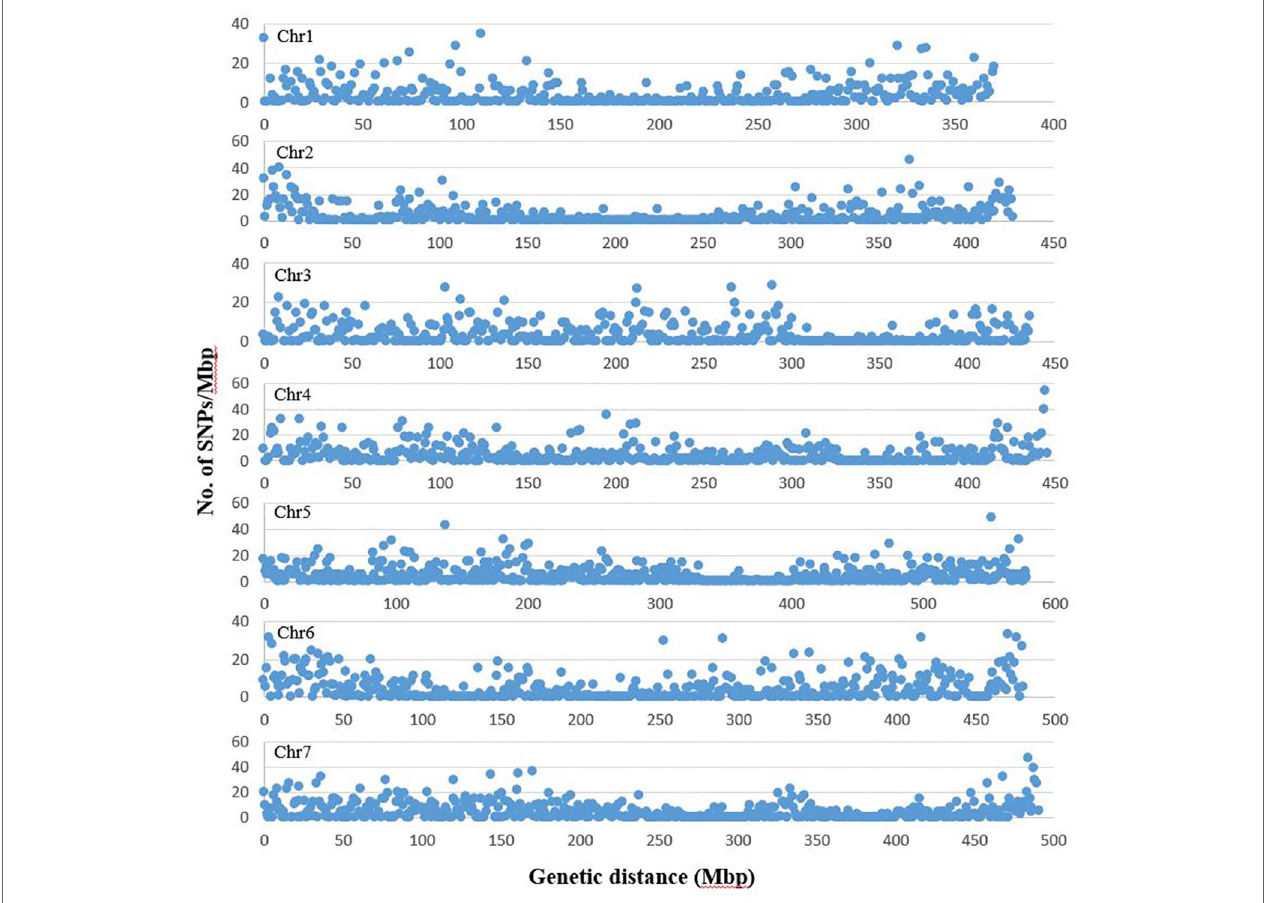
FiGUre 1 | Distribution of SNP markers selected for population structure and trait association analysis across the seven chromosomes of pea. The graph represents number of SNPs in each million bp of genetic distance of the seven pea chromosomes. The chromosome and linkage group assignment was in accordance to the pea genome assembled by Kreplak et al. (2019). The graphs are based on number of SNPs identified on chromosomes 1 to 7 (1685, 1768, 1786, 2356, 2917, 2349 and 2747, respectively).